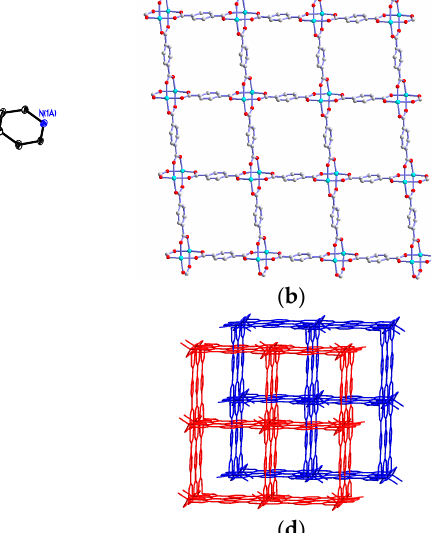
of bdc 2 − ligand used in compounds 1 – 4 .